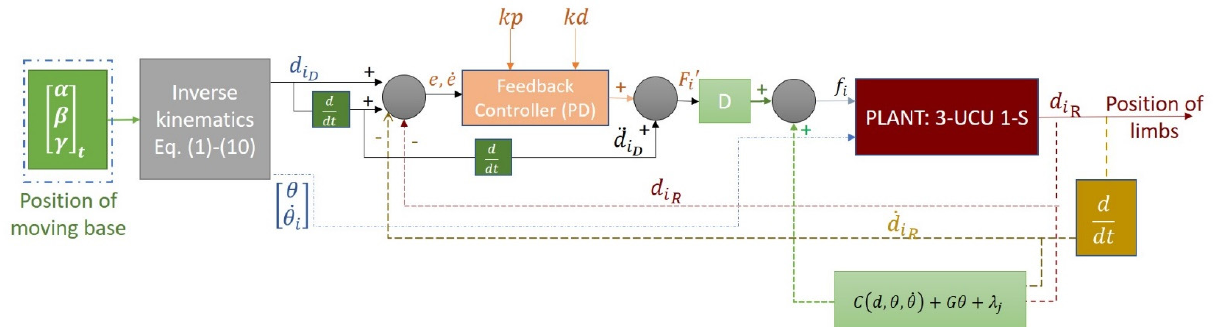
Figure 7. Block diagram for the implementation of the feedforward plus feedback controller.